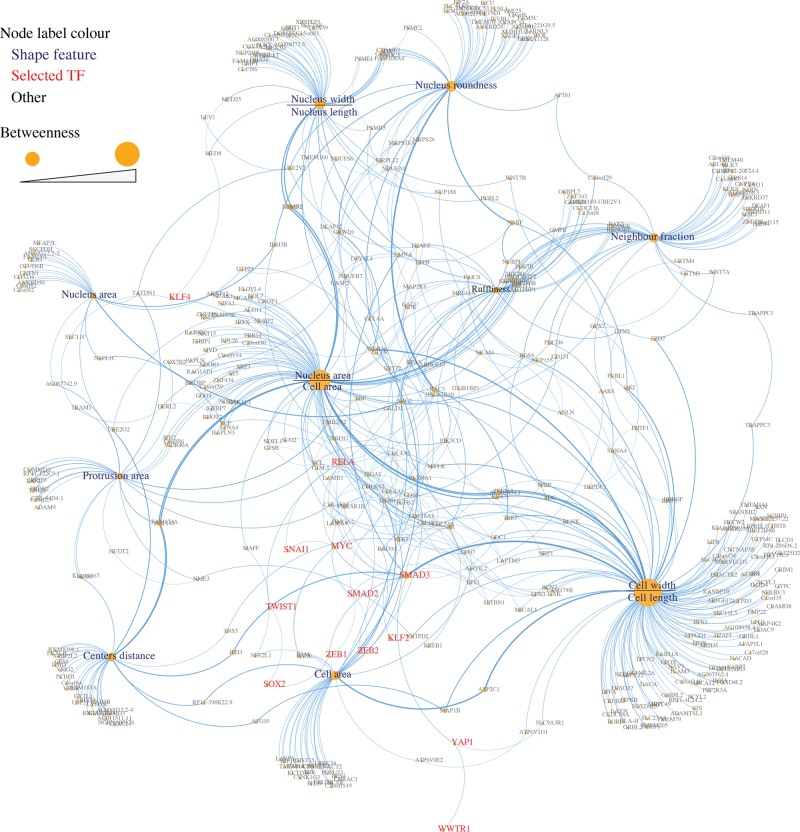
Shape-gene interaction network. A network of the interactions between the proteins encoded by shape-correlated genes, selected TFs, and shape features. Node size and font size represent the betweenness of a node, which reflects the centrality of the node.